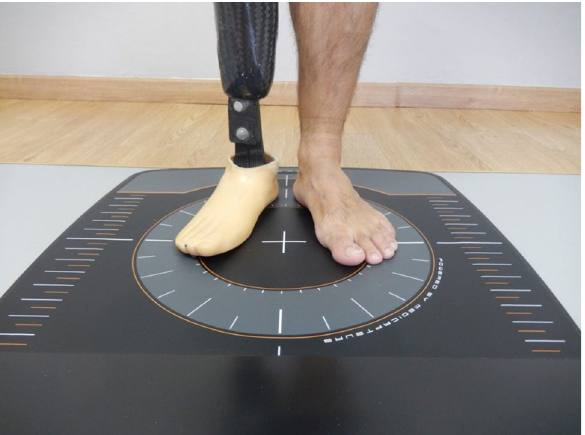
Figure 1. Baropodometry on a barefoot amputee patient in a comfortable bipedal position on the platform with both heels 2 cm apart with forefoot creating a 30° angle.